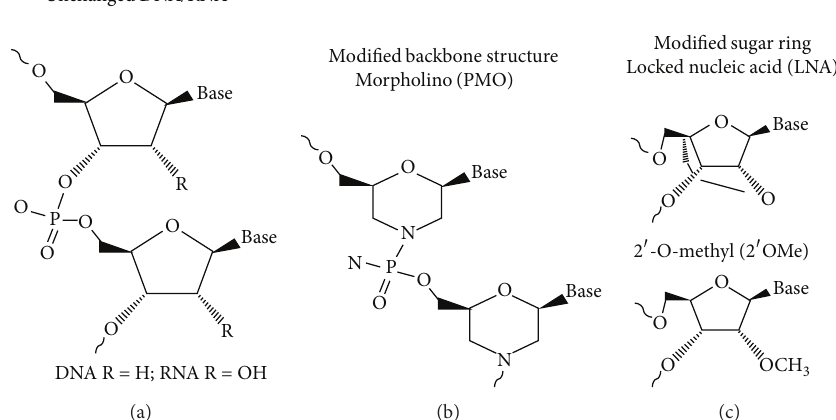
Figure 2: Chemical structures of commonly used oligonucleotides. Nucleic acids can bind to RNA targets that are complementary to their own sequence and trigger target degradation. However, unmodified DNAs/RNAs are subject to endonuclease degradation. Thus, to target RNAs, modifications to this primary structure are needed. Modifications to the nucleic acid backbone can lead to structures that can better interact with the target and are resistant to endonucleases. Modifications in the sugar ring are also possible and give rise to nucleic acids that mimic RNA, have better targeting, and are also resistant to endonuclease action.